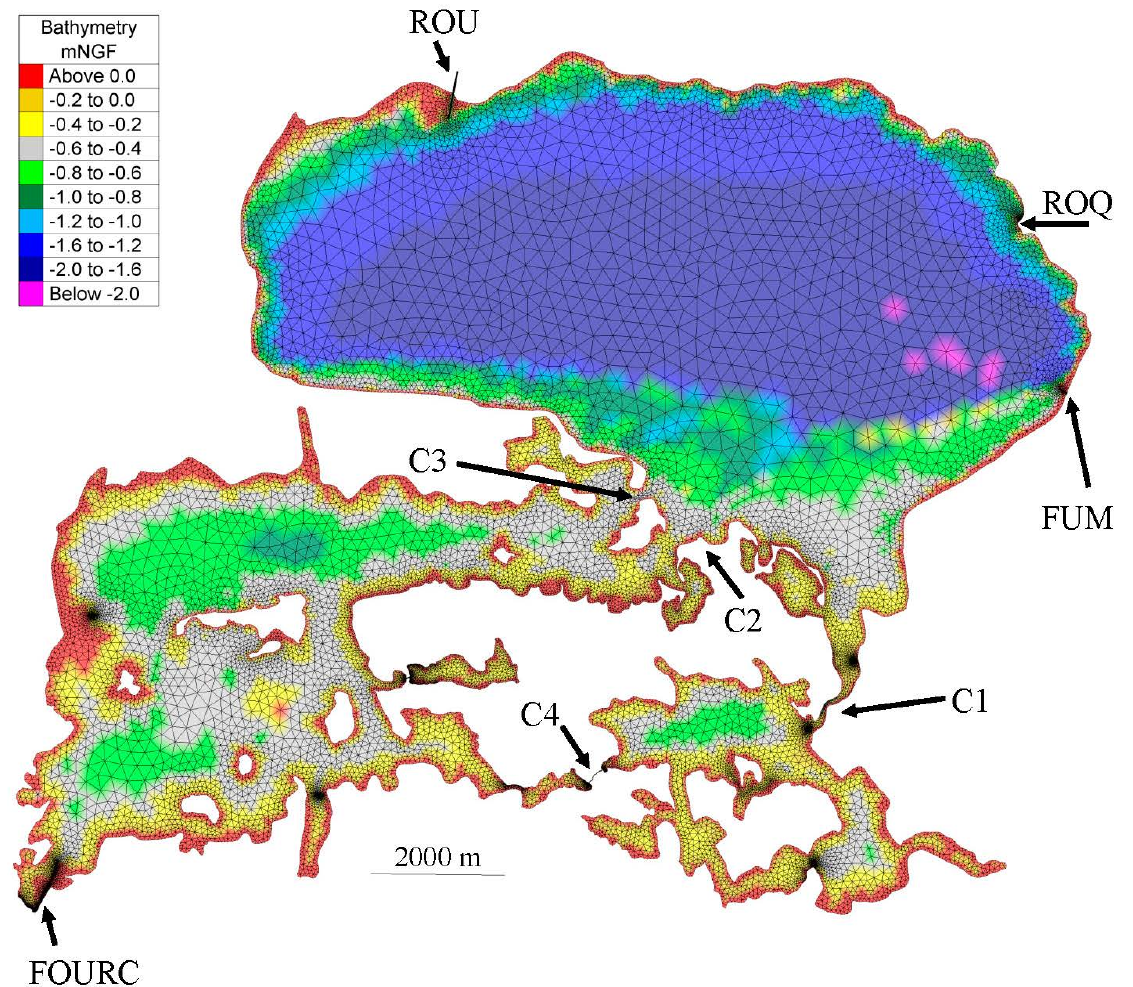
Figure 3. Unstructured mesh generated for the Vaccarès lagoon system, and resulting bathymetry. FUM and ROQ are the two drainage channels of Fumemorte and Roquemaure, and ROU is the Rousty channel. FOURC is the lagoon-sea connection at La Fourcade. For a water level in the Vaccarès lagoon system of 0.06 mNGF (mean water level in the Vaccarès lagoon system from 1993 to 2009) characteristics of C1, C2, C3 and C4 in terms of width and mean water depth are: C1 (width 32 m, mean water depth 0.77 m), C2 (width 273 m, mean water depth 0.38 m, C3 (width 129 m, mean water depth 0.40 m), and C4 (width 2 m, mean water depth 0.41